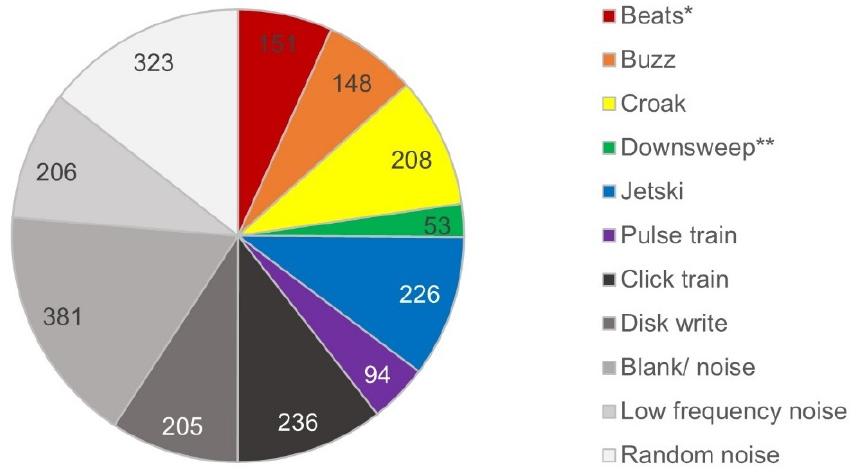
Figure 3. The number of images from the August 2010 train/test dataset used to train and test the classifier ResNet-50 for each sound type, including the six fish call types (colored; Beats, Buzz, Croak, Downsweep, Jetski, and Pulse train) and five noise types (gray scale; Click train, Disk write, Blank/noise, Low frequency noise, and Random noise). The total number of images for training and testing was 2231, with more than half of the images representing a noise type. * Majority of Beats calls were from August 2010 train/test dataset, but 32 were from the evaluation dataset. ** Approximately half of the Downsweep images were from the August 2010 train/test dataset and the other half was from other periods in the long-term dataset.